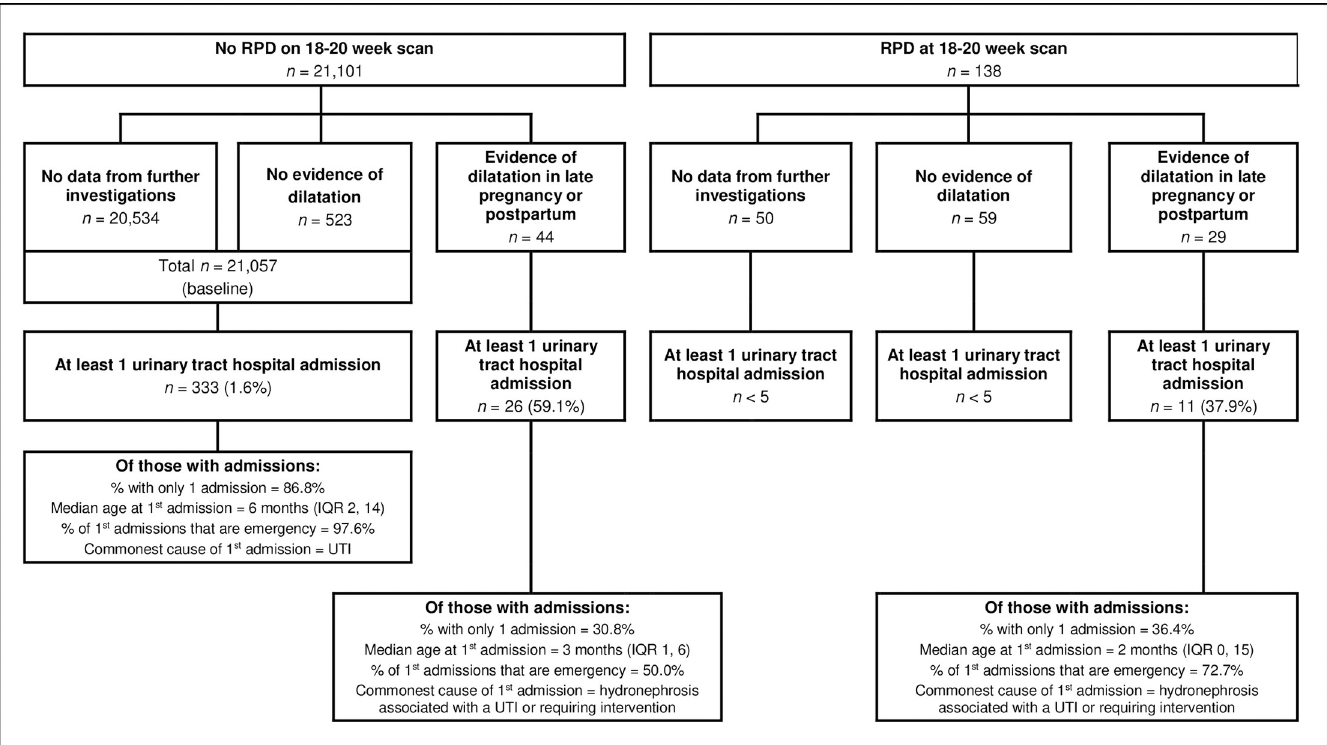
Fig 2. Definition of exposure groups for the analysis, and characteristics of hospital admissions. IQR, interquartile range; RPD, renal pelvis dilatation; UTI, urinary tract